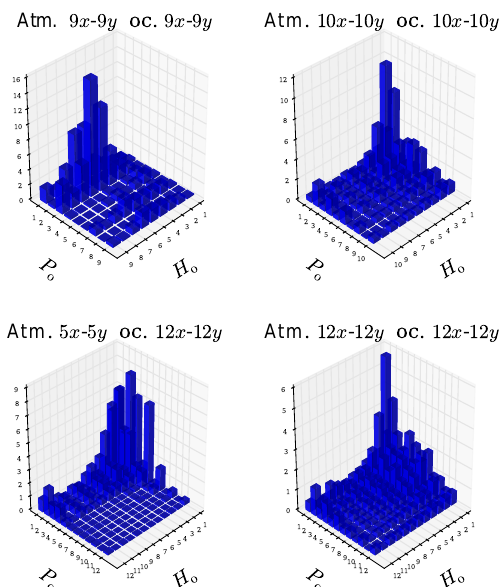
Figure 14. Climatologies for the oceanic streamfunction ψ o field (m 2 s − 1 ) presented on the non-dimensional model domain for the high-resolution runs displayed in Fig.